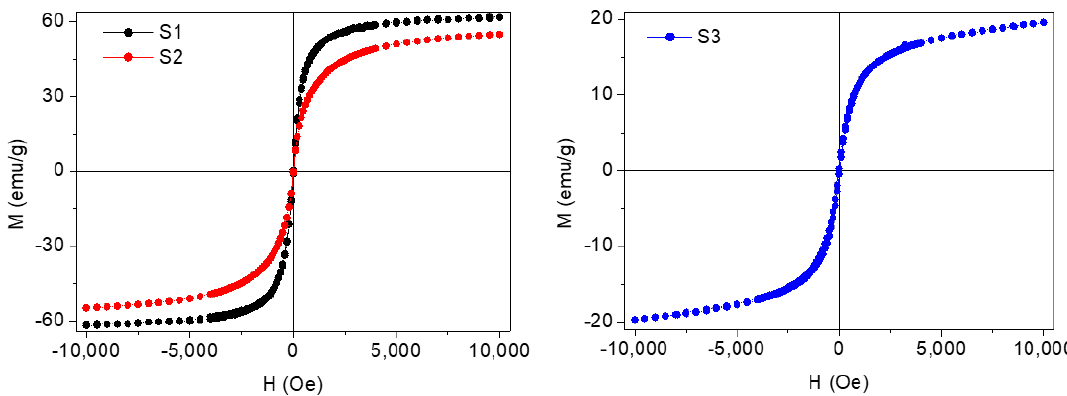
Figure 5. Magnetization curves at room temperature for the coated F 3 O 4 nanoparticles: (S1) 6.3 nm and (S2) 10 nm and (S3) Nd alloy.